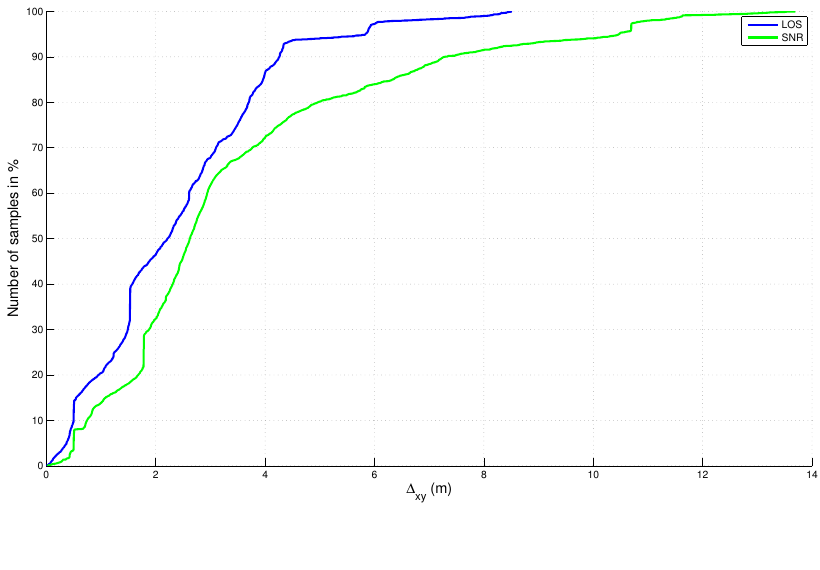
Figure 10. Cumulative distribution function of the absolute error in 2D for map-aided solutions.